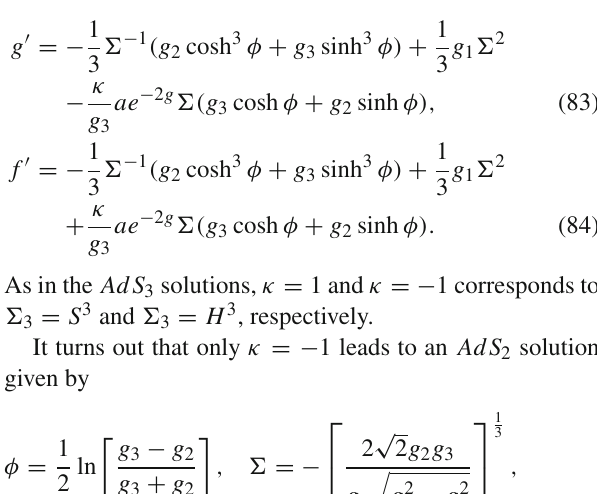
Fig. 6 An RG flow from AdS 5 critical point with U ( 1 ) × SU ( 2 ) × SU ( 2 ) symmetry to AdS 3 × S 2 critical point III for g 1 = 1, g 3 = 2 g 1 and a 5 = 1